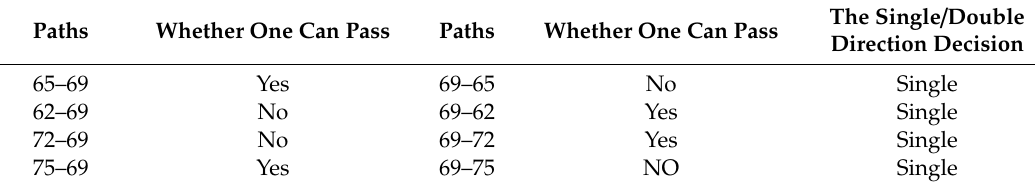
Figure 18. Intersection 69. Table 3. The single / double direction decision.